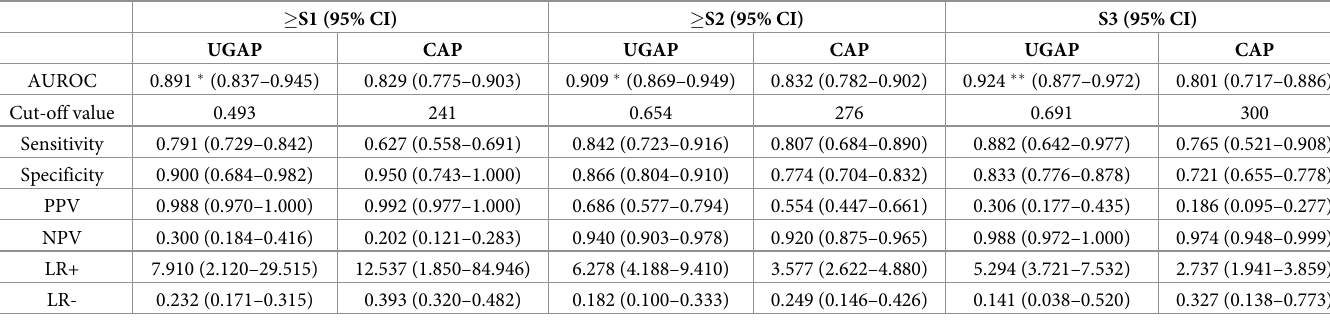
Table 3. Diagnostic accuracy of UGAP and CAP for the diagnosis of steatosis